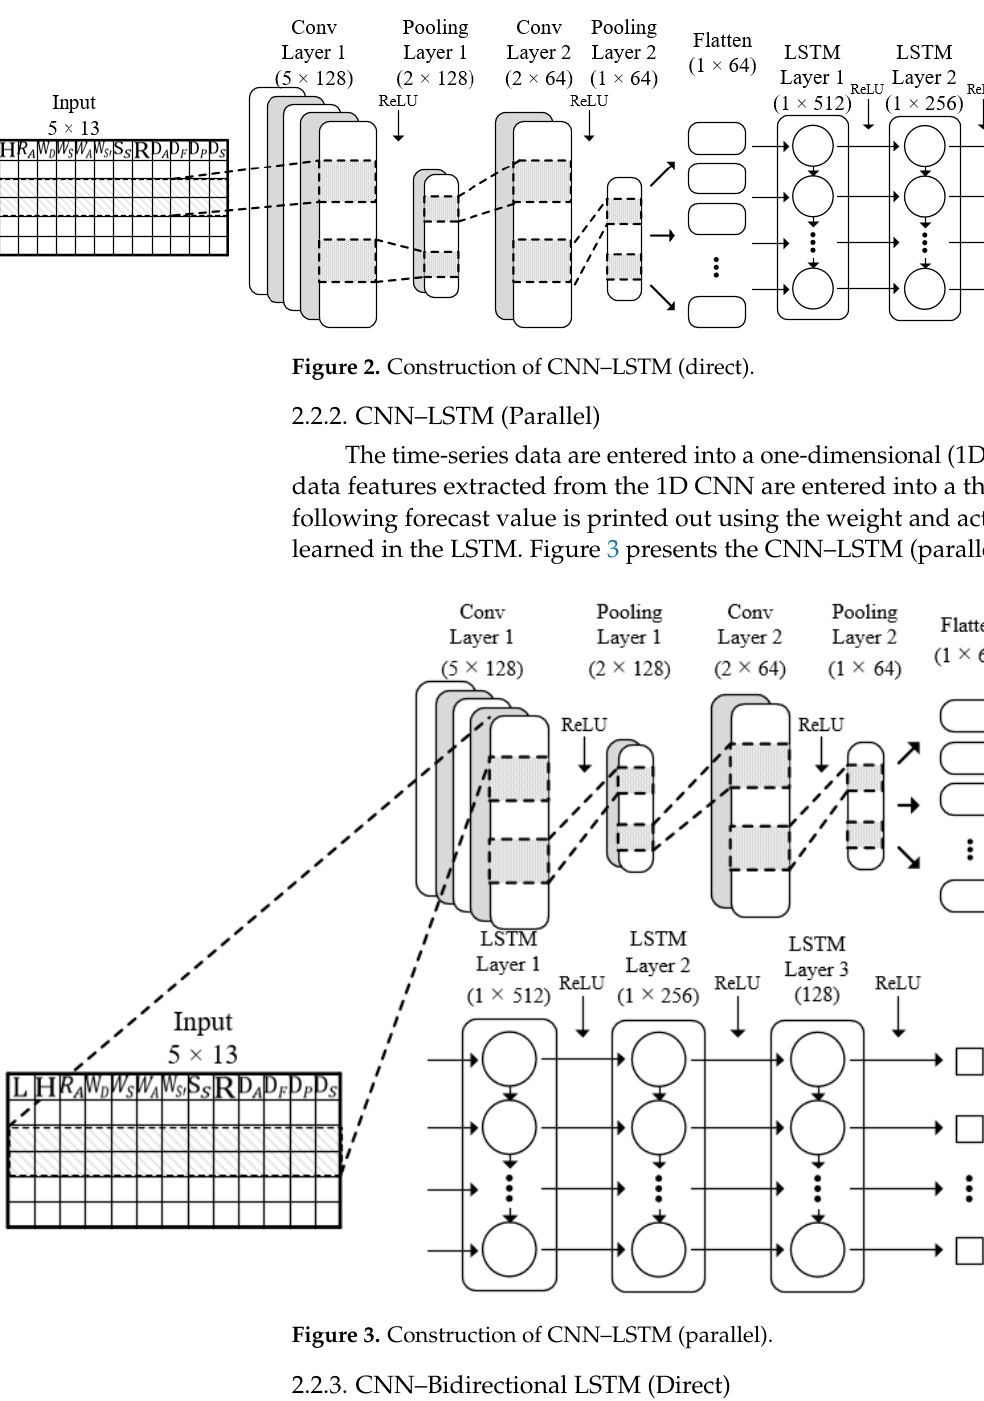
Figure 2. Construction of CNN–LSTM (direct).